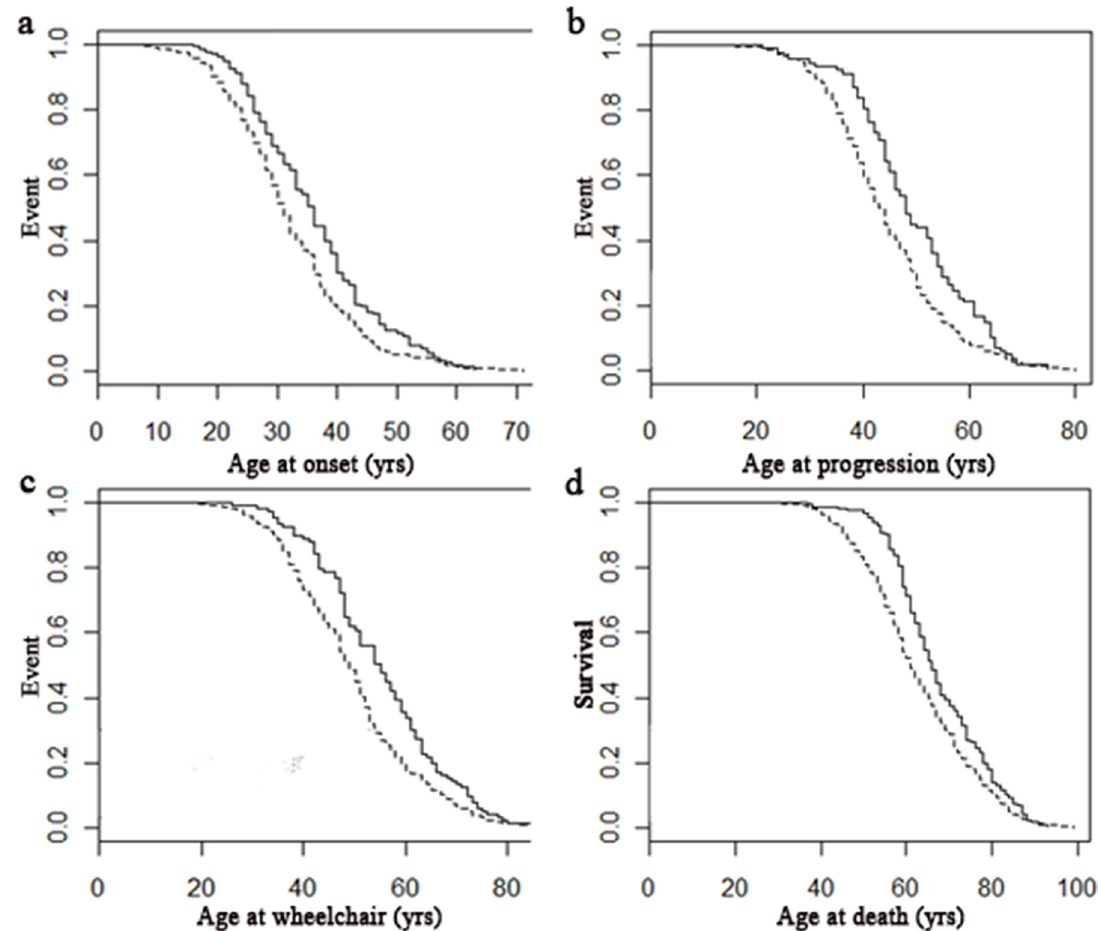
Fig 2. Cox proportional hazard regression models of disease milestones in those who progressively dwindle compared to other trajectories. Those who progressively dwindle had an earlier age at onset (A, R 2 = 0.02, n = 504, p < 0.01;